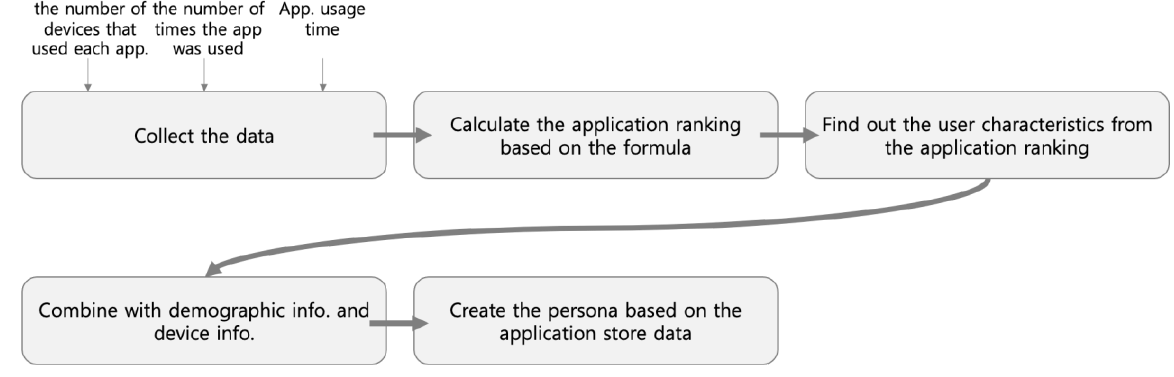
Figure 2. Process of creating a persona.